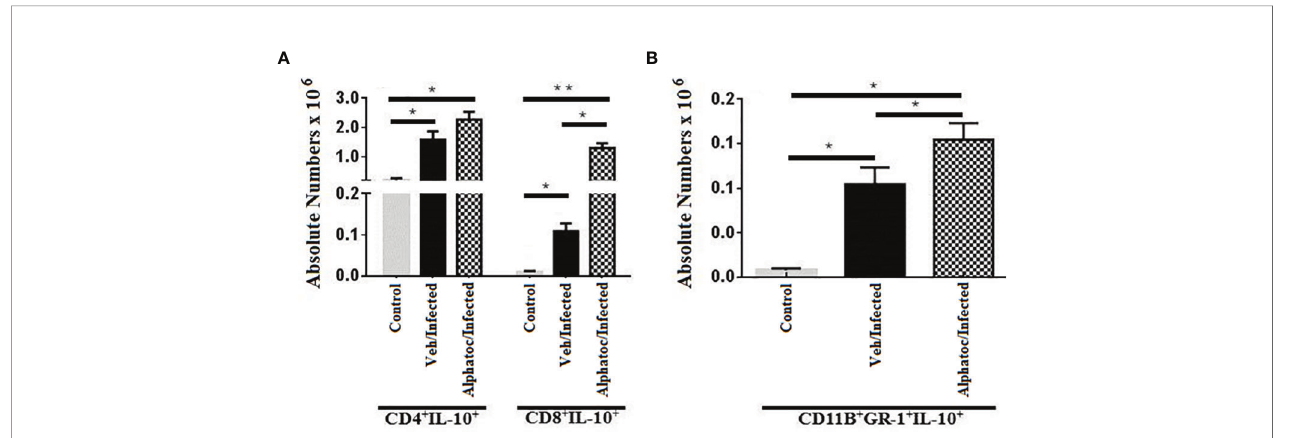
FIGURE 6 | Numbers splenic T cells and MDSCs, expressing IL-10. (A) shows the numbers of IL-10 producing CD4 + and CD8 + splenic T lymphocytes after 60 days of infection with 10 3 forms of T. cruzi . IL-10-producing Gr1 + CD11b + (MDSC) splenic cells are shown in (B) . All groups were individually compared (**P < 0,01, *P < 0,05, Mann Whitney test, n=